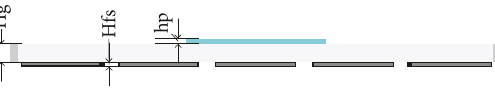
Figure 4: The side view of the proposed antenna.